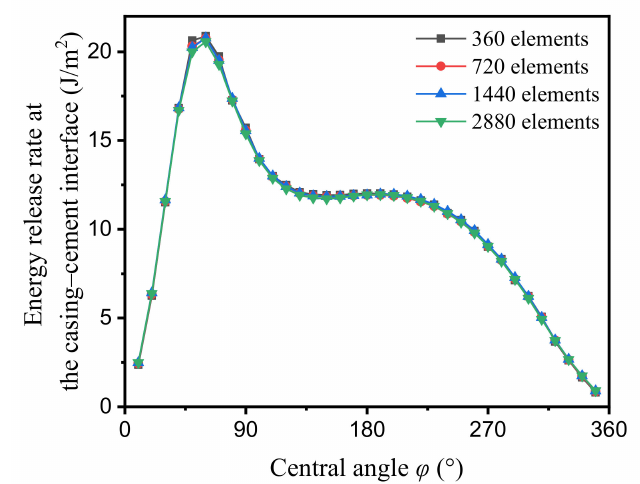
Figure A1. Energy release rate estimated with di ff erent element